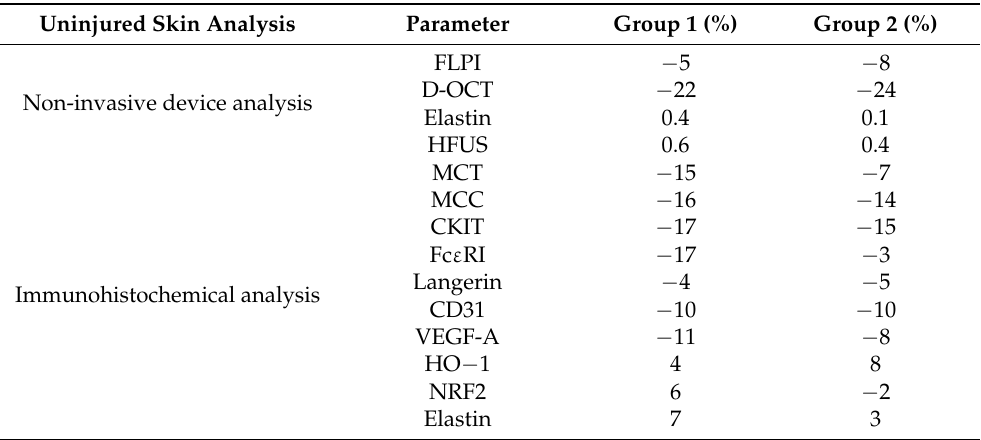
Table 7. Uninjured skin analysis. Table displaying the percentage differences between EGCG treated uninjured skin and placebo treated uninjured skin in Groups 1 and 2 pre-emptive priming groups for different parameters measured. Group 1 (Pre-injury: pre-emptive priming 7 days), Group 2 (Pre-injury: pre-emptive priming 3 days). Parameter Group 1 (%) Group 2